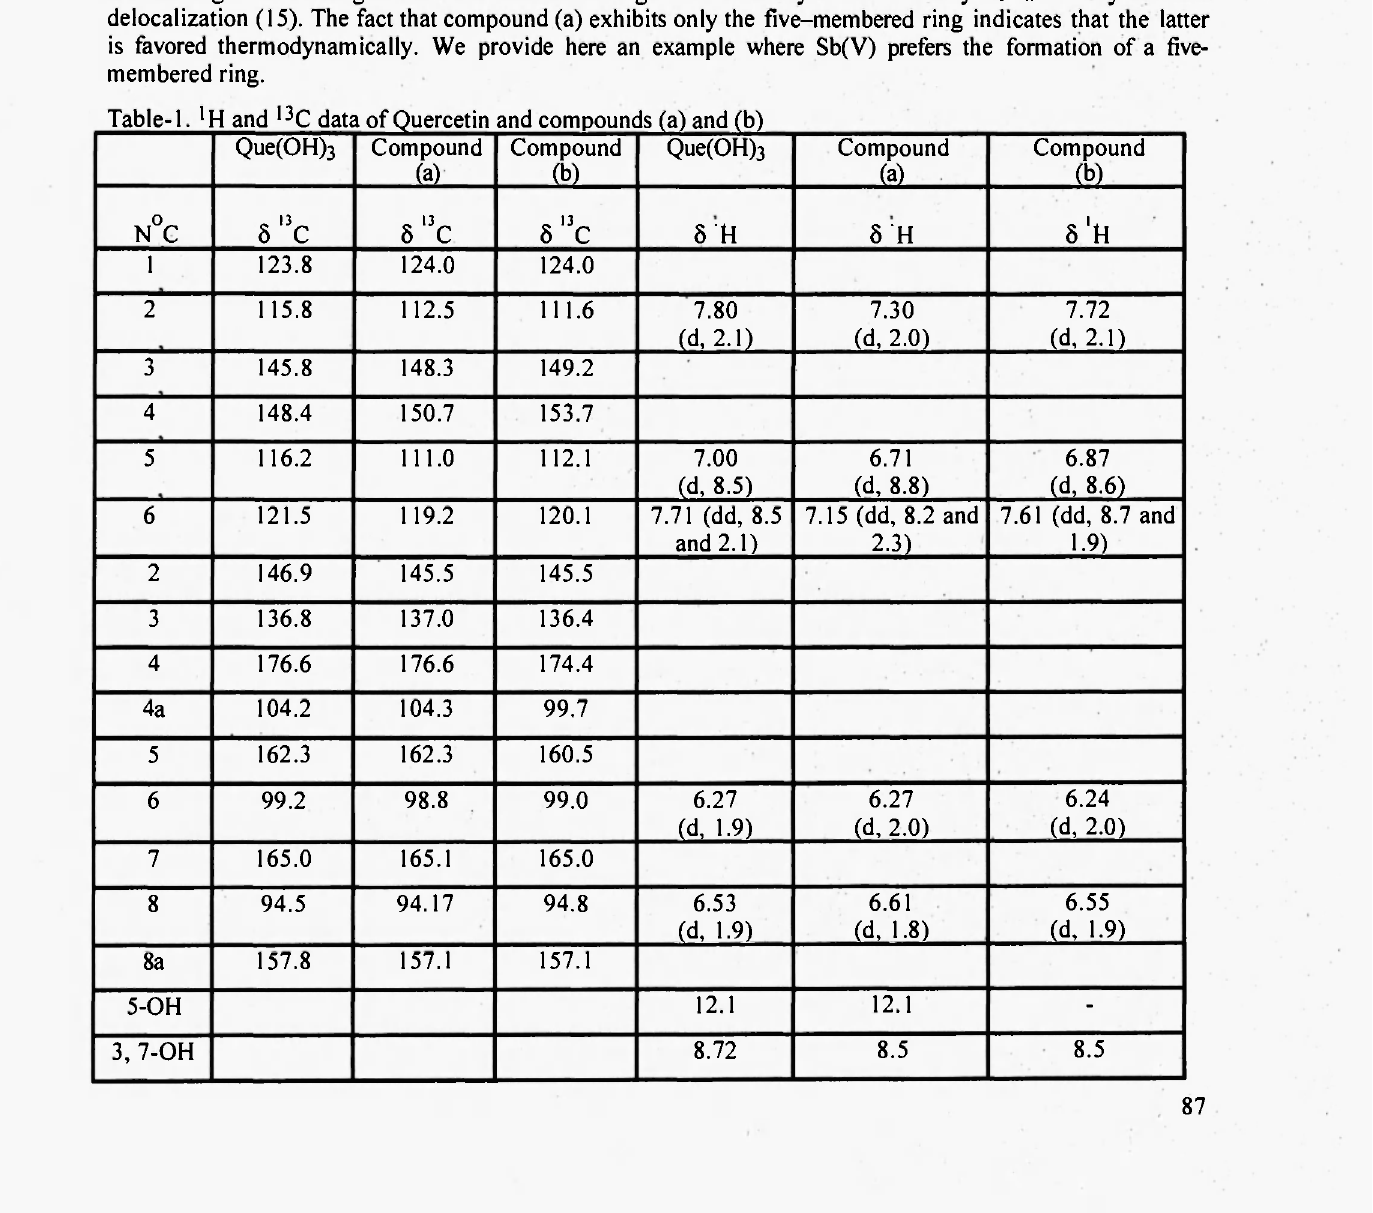
Table-1. *H and 13 C data of Quercetin and compounds (a) and (b) Que(OH)